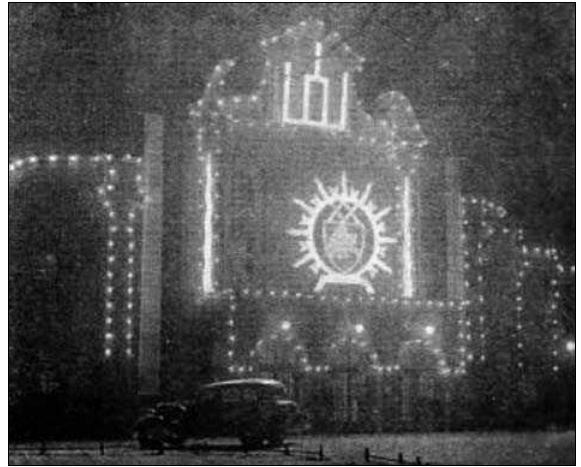
Fig. 12. kaunas State Musical theatre,